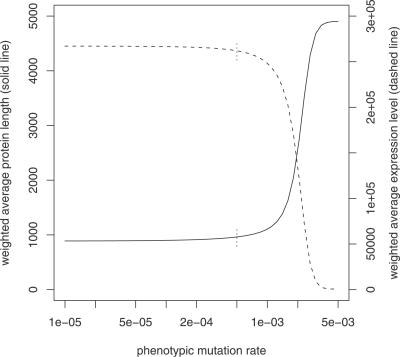
Weighted Averages of Protein Length (10) and Expression Level (11)To determine which protein and expression levels are most relevant for the amount of abnormal proteins in a cell, we calculated weighted averages of protein length (solid line) and expression level (dashed line). As weights, we used the amount of expected abnormal proteins,
. For small phenotypic mutation rates, highly expressed proteins are most relevant for the amount of abnormal proteins in a cell. This begins to change at u = 5 × 10−4, when lowly expressed, large proteins begin to dominatex̄. Inaccurate protein synthesis makes it practically impossible to synthesize these larger proteins error-free.